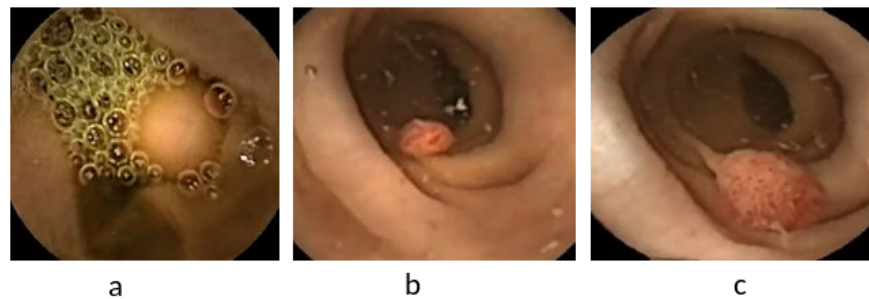
Figure 7. Example of WCE polyp images ( a – c